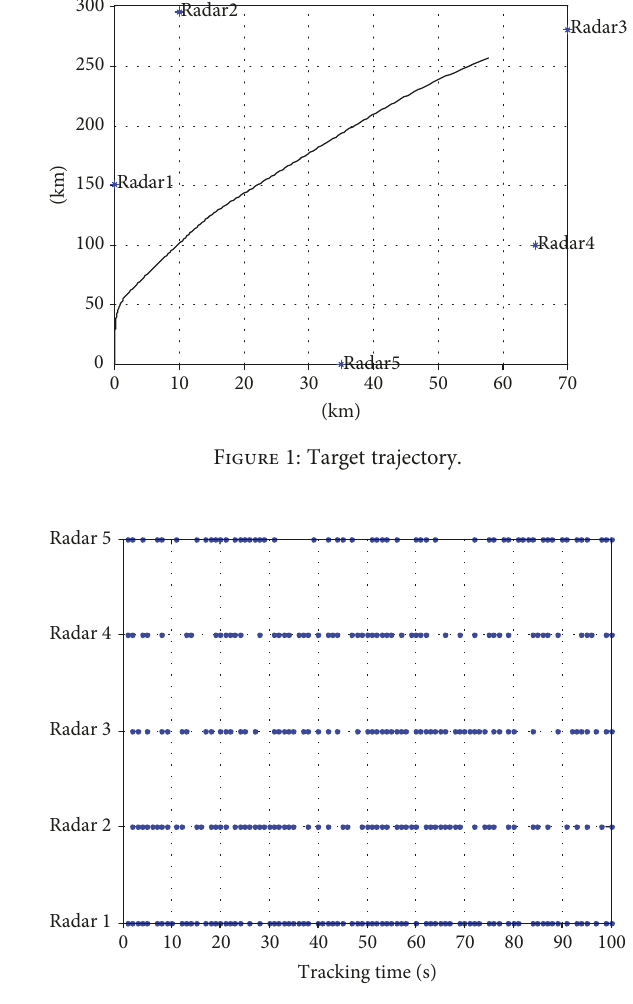
Figure 2: Radiation label of the radars.